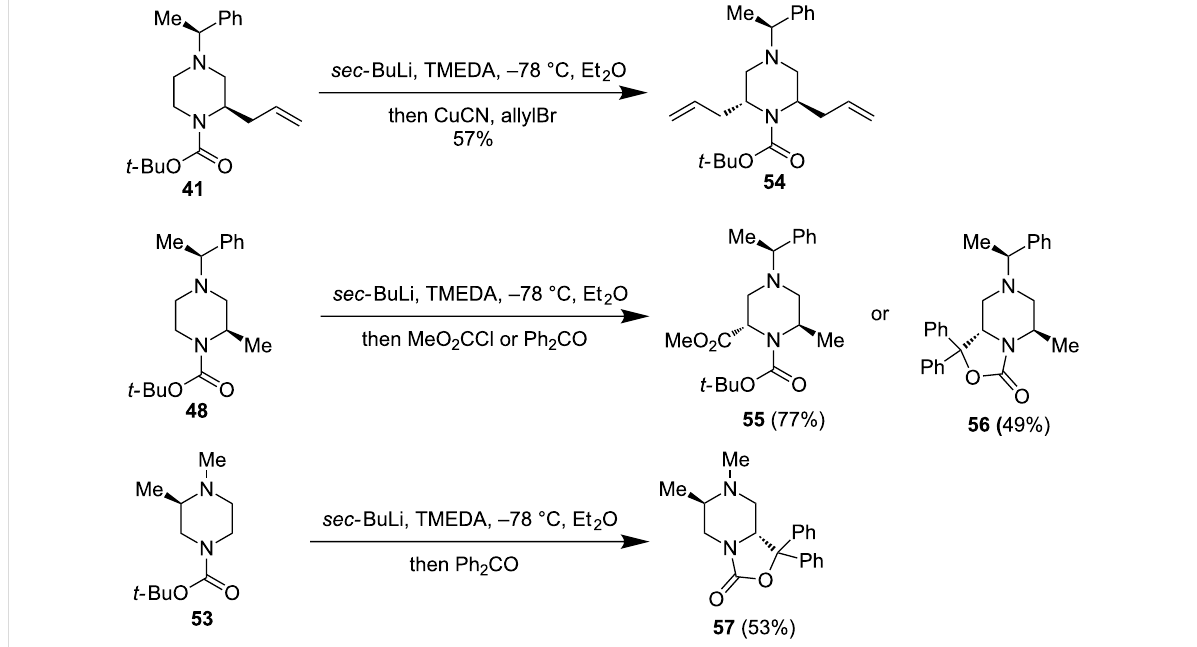
a fertile research field [45-47]. In the case of saturated N -heterocycles however, most of the efforts have been focused on directed α -C–H functionalization of pyrrolidines and piperidines [48-50]. Little progress has been made in transition- metal-catalyzed α -C–H functionalization of piperazines presum- ably due to the low reactivity and the undesired competitive pathways caused by the addition of the second nitrogen in the six-membered ring [51]. As of yet only a few examples have been reported so far and are far from being general and prac- tical; no enantioselective versions have been